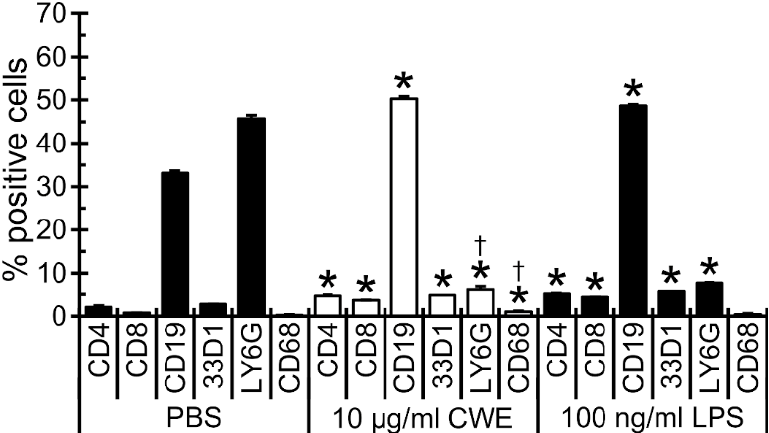
Figure 4. CWE treatment increased various immune cell populations in primary cultured mouse bone marrow cells (BMCs). Percentage of the population of BMCs treated with 10 µg/mL CWE and 100 ng/mL LPS for 48 h were evaluated by flow cytometry. These BMCs were labeled with various antibodies and relative quantities were analyzed by flow cytometry. PBS and LPS served as negative and positive controls, respectively. *, p < 0.05 compared to PBS control group; †, p < 0.05 compared to LPS-treated group ( n = 3).